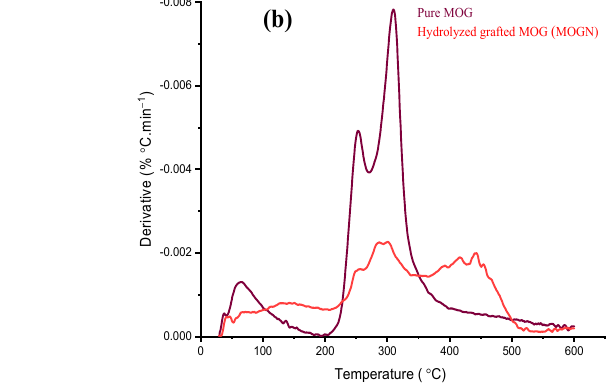
Figure 5. Thermal analysis of the pure MOG and MOGN ( a ) TGA and ( b ) DTG curves.